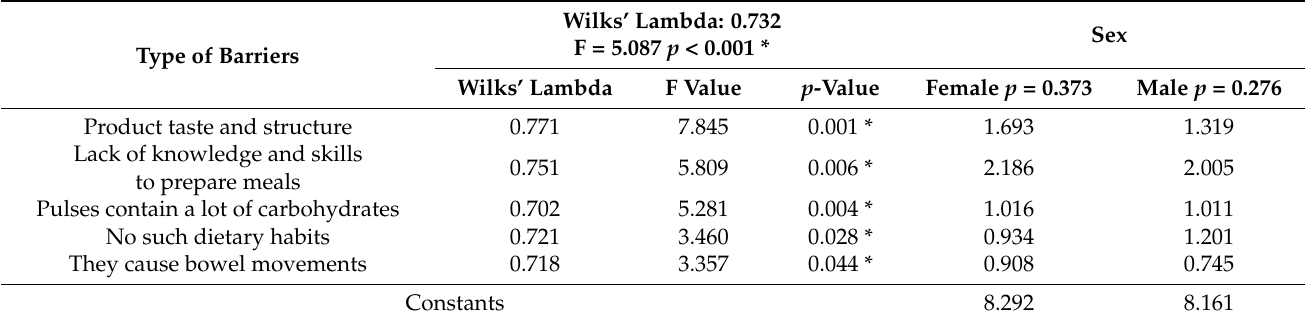
Table 4. Barriers to consuming meals containing pulse products among